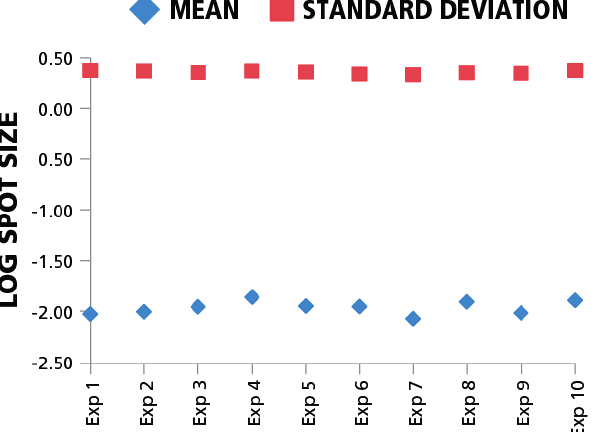
Figure 5. Mean spot sizes for the same donor/peptide combination show minimal variation between experiments. Ten independent experiments were performed testing repeatedly the HCMV pp65 induced IFN- γ recall response of the same PBMC donor. The mean spot sizes in mm 2 (diamonds) and SD (squires) are shown in the logarithmic scale (y-axis) vs. experiment ID (x-axis). For each data point 1000 spots were used to build spot size